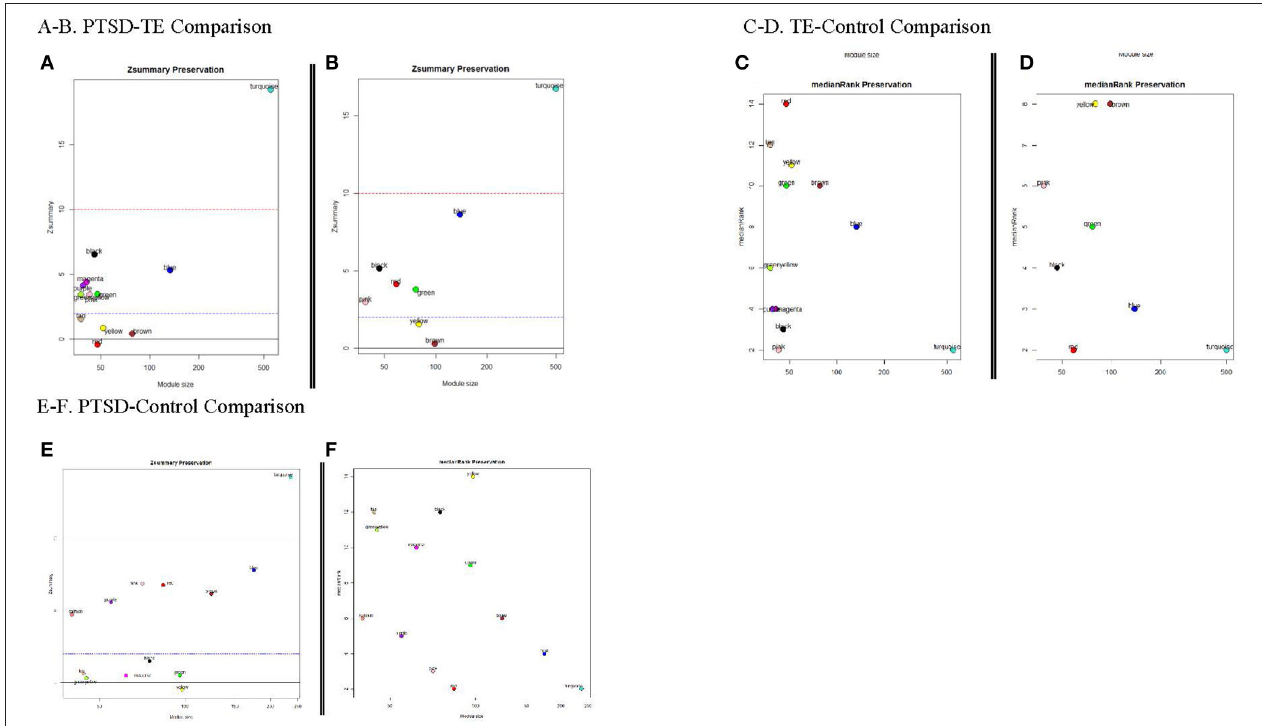
FIGURE 3 | Module Preservation Statistics. Zsummary and medianRank are two mutually complementing preservation statistics to assess module preservation, using either TE or the Cont modules as reference. Y-axis represents preservation statistics for the corresponding module(s) in the case set, and x-axis is the gene numbers in each module. The dashed blue and red lines indicate the thresholds Z ≤ 2 and Z ≤ 10, respectively (see text for more details). (A,B) Zsummary and medianRank preservations statistics for PTSD/TE comparison, respectively; (C,D) Zsummary and medianRank preservations statistics for TE/Cont comparison; (E,F) Zsummary and medianRank preservations statistics for PTSD/Cont